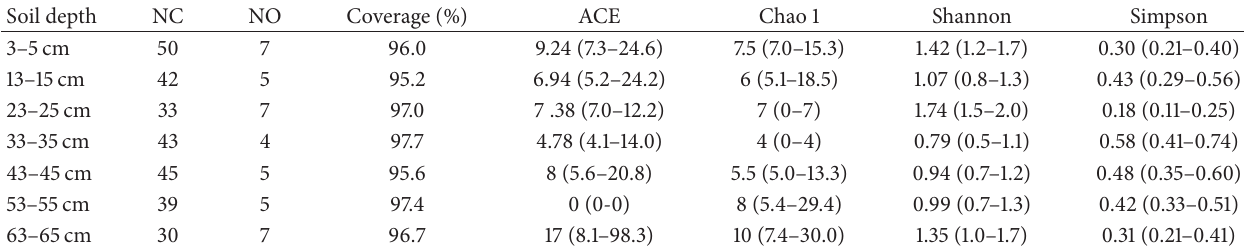
Table 2: Sequencing information and statistical analyses of archaeal 16S rRNA gene clone